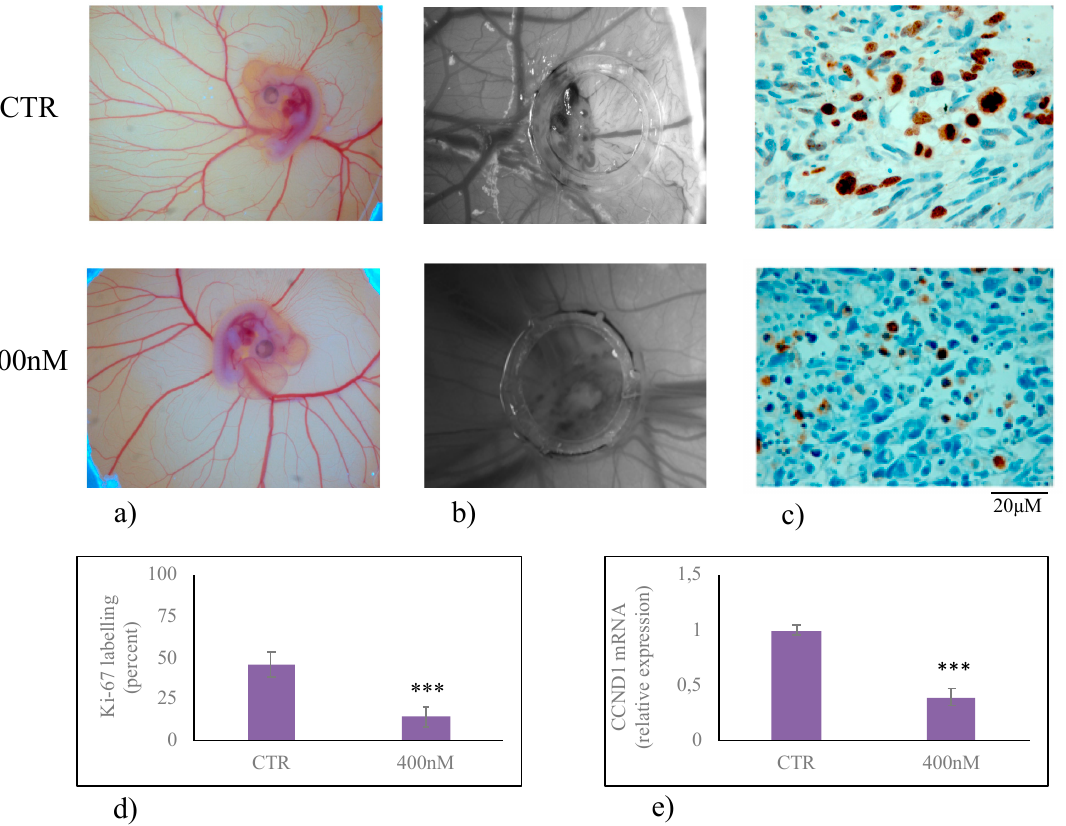
Figure 6. Xenotransplantation in chorioallantoic membrane (CAM) of U251 cells treated or not with 400 nM 1 α ,25(OH) 2 VD 3 . Experiments were performed as reported in the material and methods. ( a ) Image of embryo and CAM vessels on the eighth day from fertilization; ( b ) U231 cells photographed in ovo after 12 days from transplantation; ( c ) immunohistochemistry analysis of U231 cells in CAM fixed in ovo after 12 days from transplantation; ( d ) percentage of labelling; ( e ) CCND1gene expression performed by RTqPCR analysis. Data were expressed as the mean ± S.D. of 3 independent experiments performed in duplicate. ∗∗∗ p < 0.001.